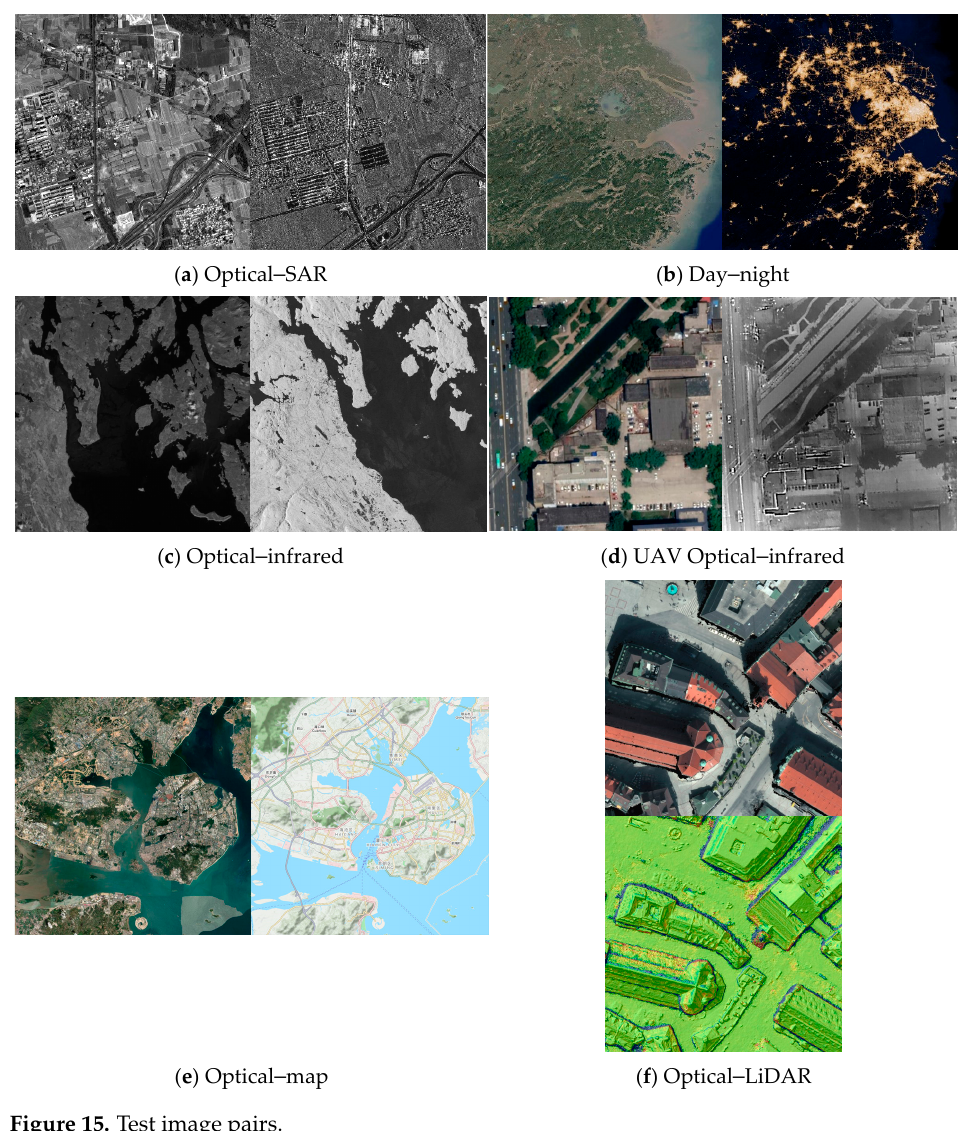
pixels. Table 2. Description of test data. Category